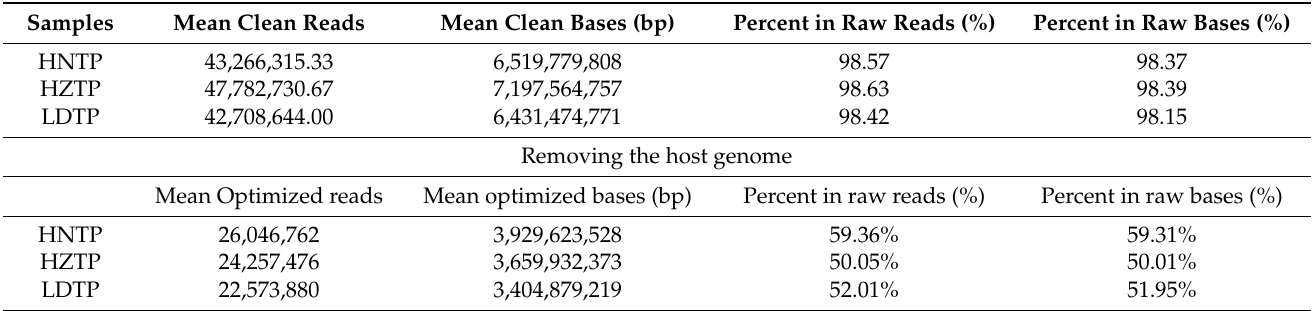
Table 1. Sequences data overview of Tianpei